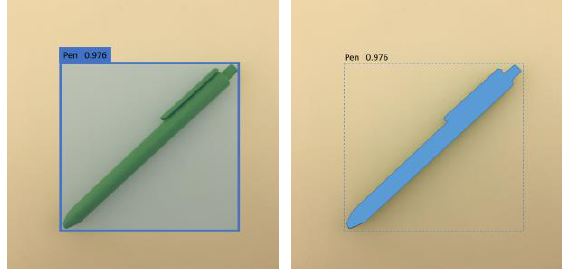
Figure 1: Bounding box created by a conventional deep CNN (left) and close contour mask created by mask R-CNN